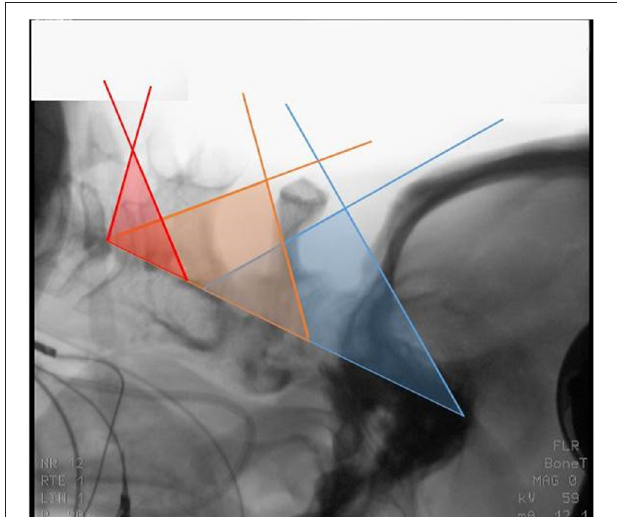
FIGURE 1 | Lateral X-ray of case 4 after prone positioning with inclination. Colored sectors indicate the theoretical access supplied by the interspace between the occiput and the posterior arch of C1 (blue), C1 and the cranial edge of the lamina of C2 (yellow) and, at times, between the inferior edge of the lamina of C2 and the superior edge of the lamina of C3